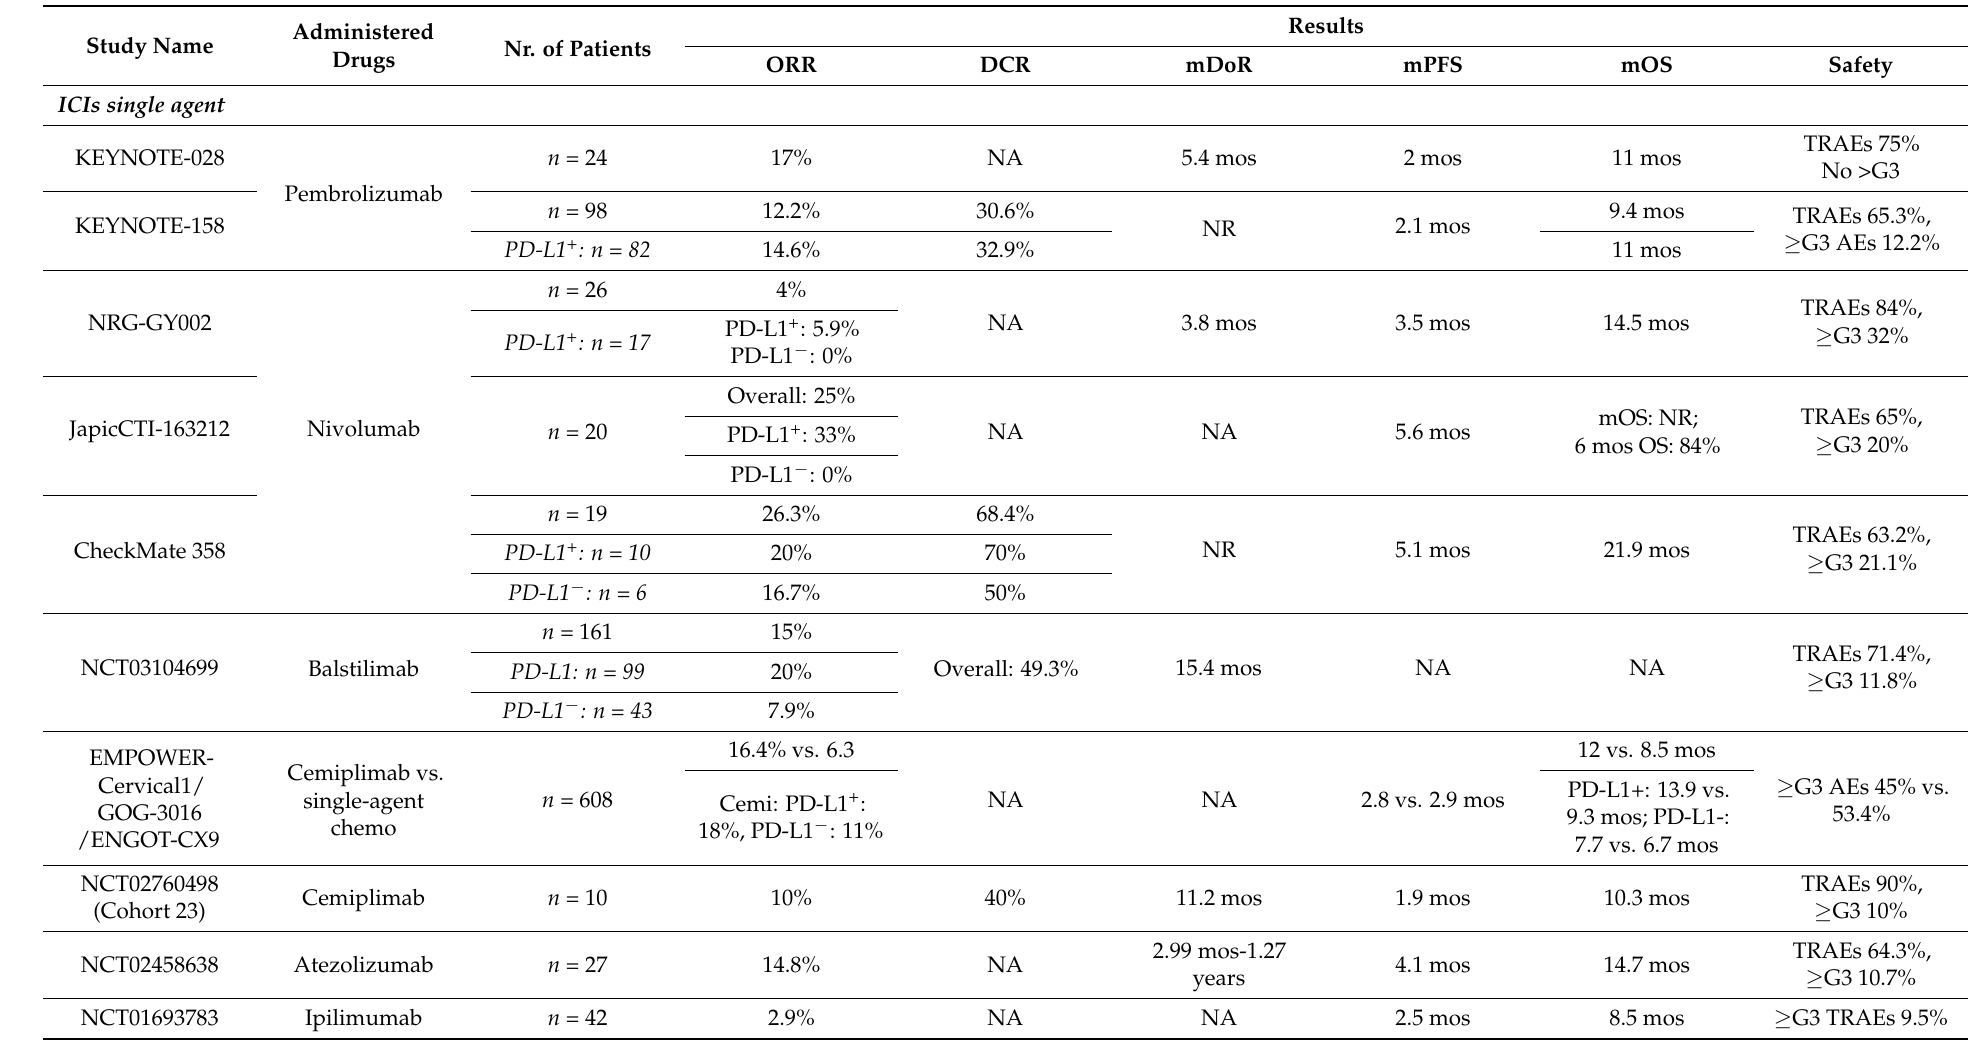
Table 2. Results of included trials of ICIs in advanced